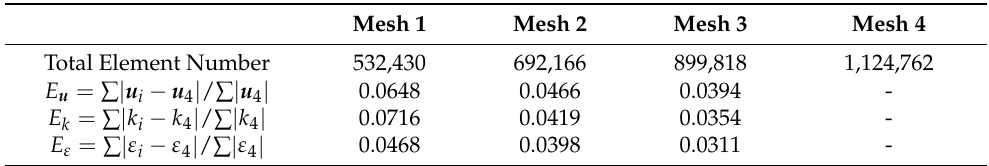
Table 2. Error statistics of flow field for different